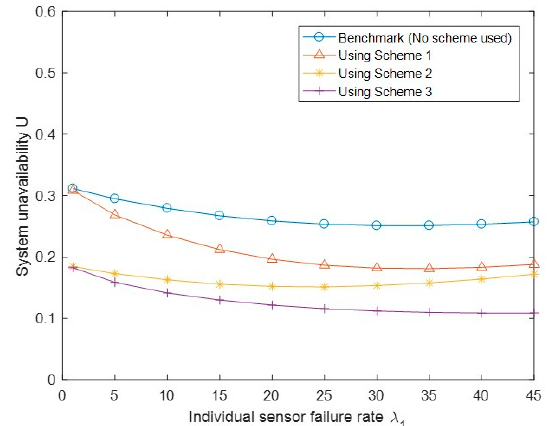
Figure 15. Performance comparison of the system unavailability U under the benchmark and three API schemes.